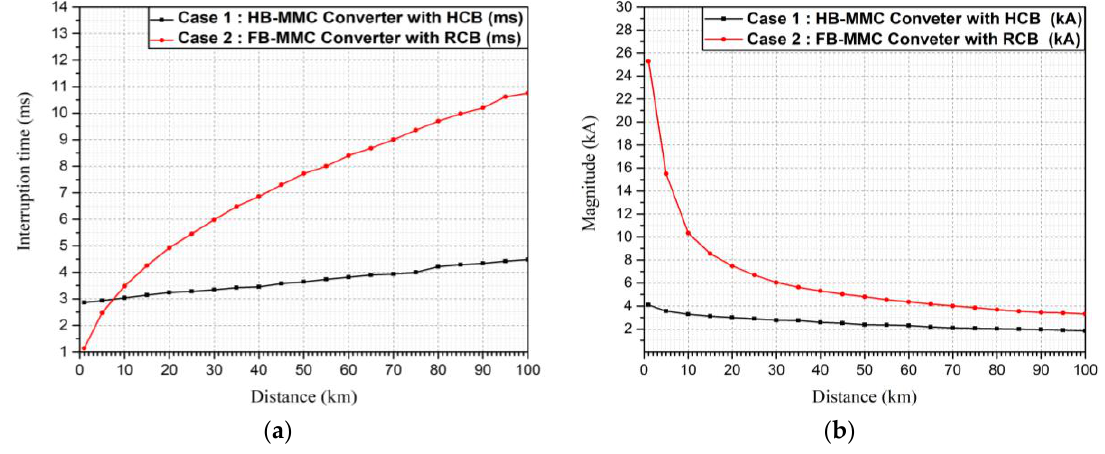
Figure 9. Comparison analysis of interruption characteristics according to the location of the fault on the DC line: ( a ) interruption time; ( b ) maximum fault current magnitude.